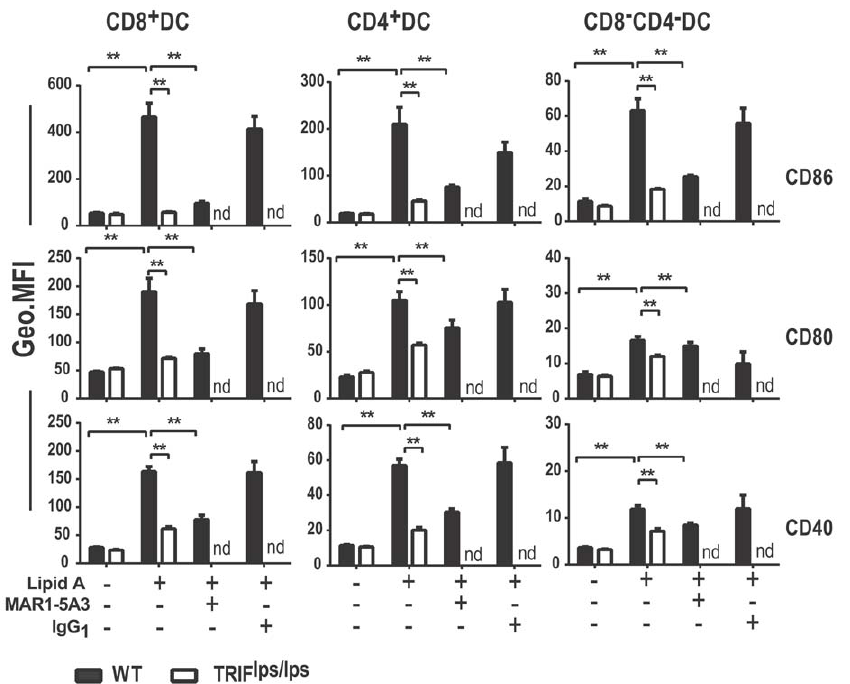
Figure 6. Type I IFN receptor signal is required for TLR4-TRIF mediated upregulation of co-stimulatory molecules in vivo. C57BL/6 and TRIF lps/lps mice were pre-treated with MAR1-5A3 mAb or isotype control and then injected with lipid A (10 m g/mouse) or saline. After 12 h, splenocytes were labeled with fluorochrome conjugated Abs to measure CD80, CD86, and CD40 expression by DC subsets. The data are representative of 2 independent experiments with 3 replicates in each treatment; nd, not determined. Statistical significance between the treatments at each time point was calculated by two-way ANOVA; **; p-value # 0.01 and *; p-value # 0.05 confidence interval.